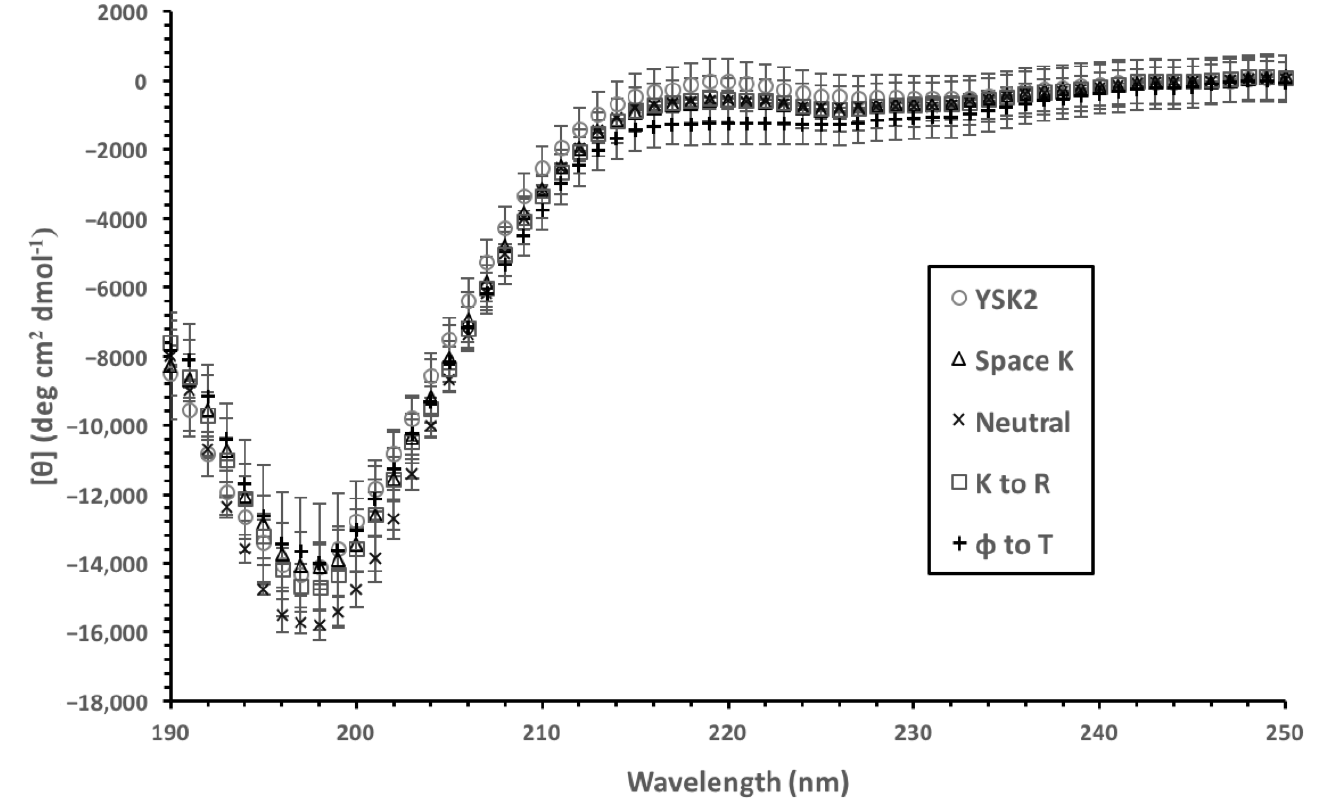
Figure 2. Comparison of the disorder of the wild-type YSK 2 and the constructs. CD spectra of 10 μM protein in 10 mM Tris, pH 7.4, were collected at 25 °C. Symbols are shown as an inset. Each spectrum is an average of three replicates with six accumulations each. Error bars represent the standard de- viation.